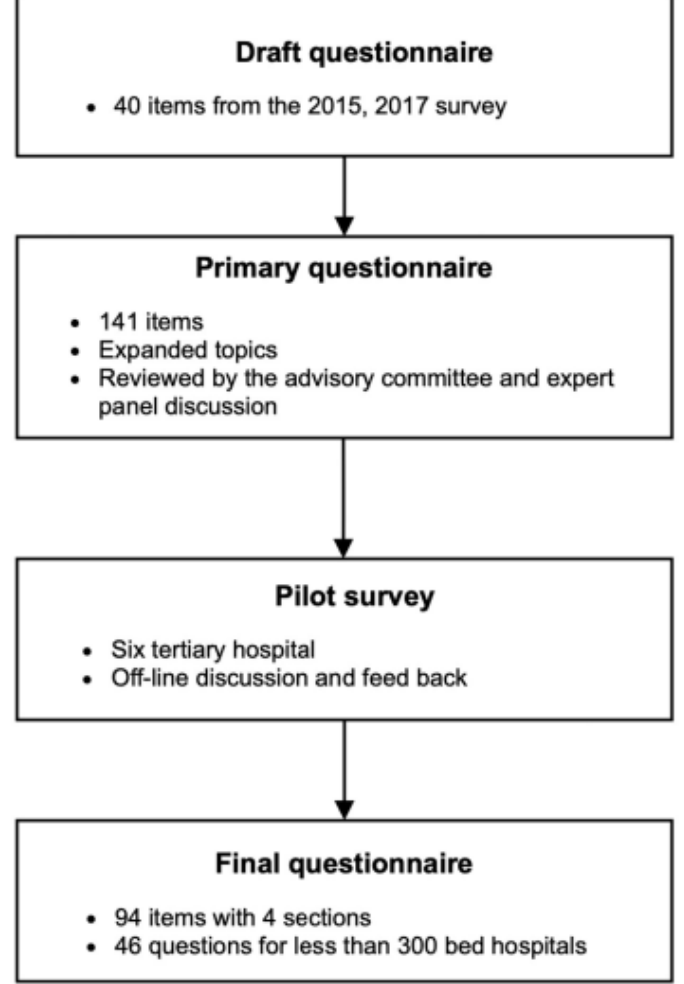
Figure 1. The survey questionnaire design